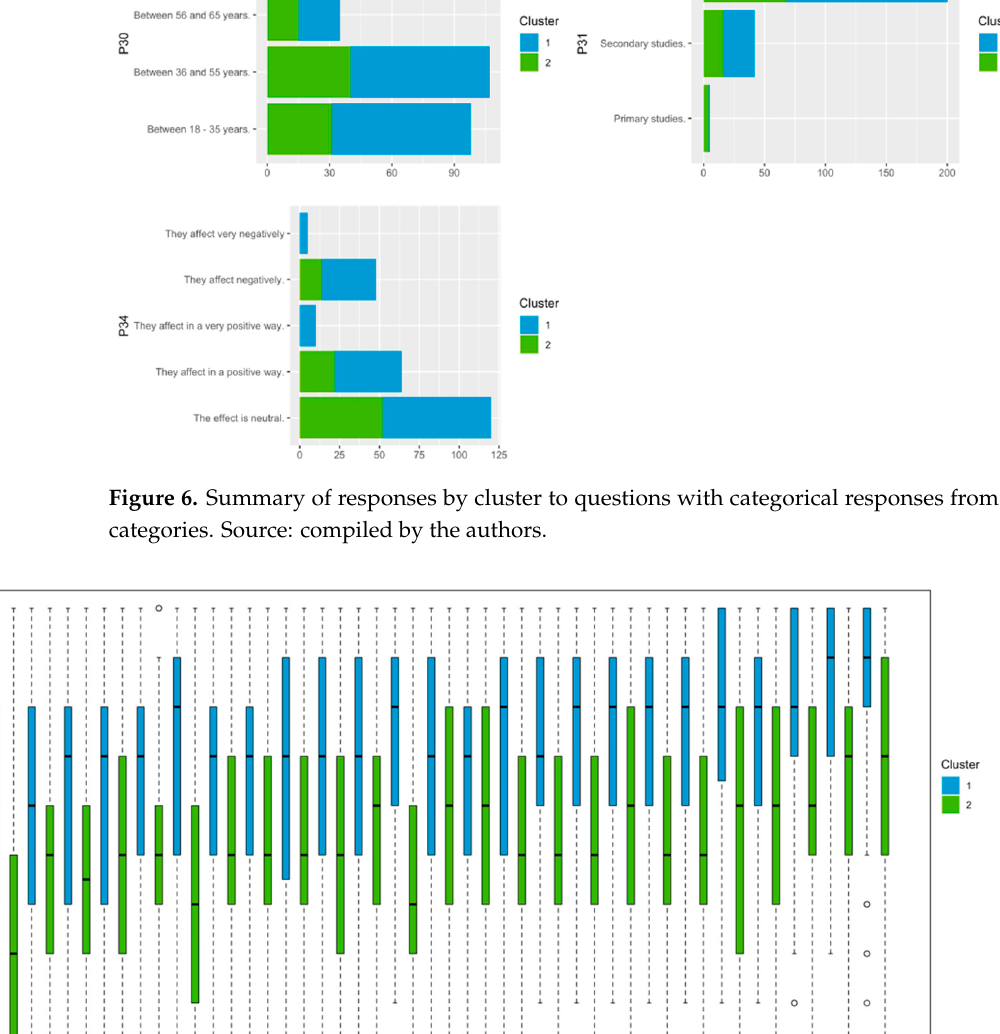
Figure 7. Summary of answers by cluster to the questions with quantitative answers (0–10). Source: compiled by the authors.